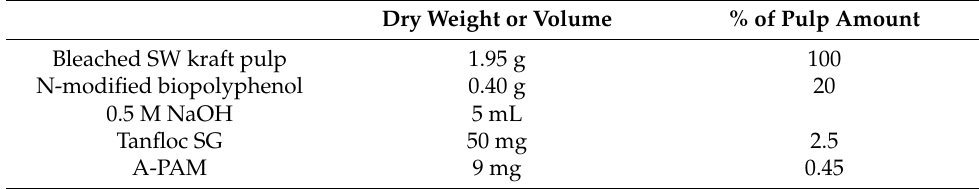
Table 6. Formulation in Lignobond